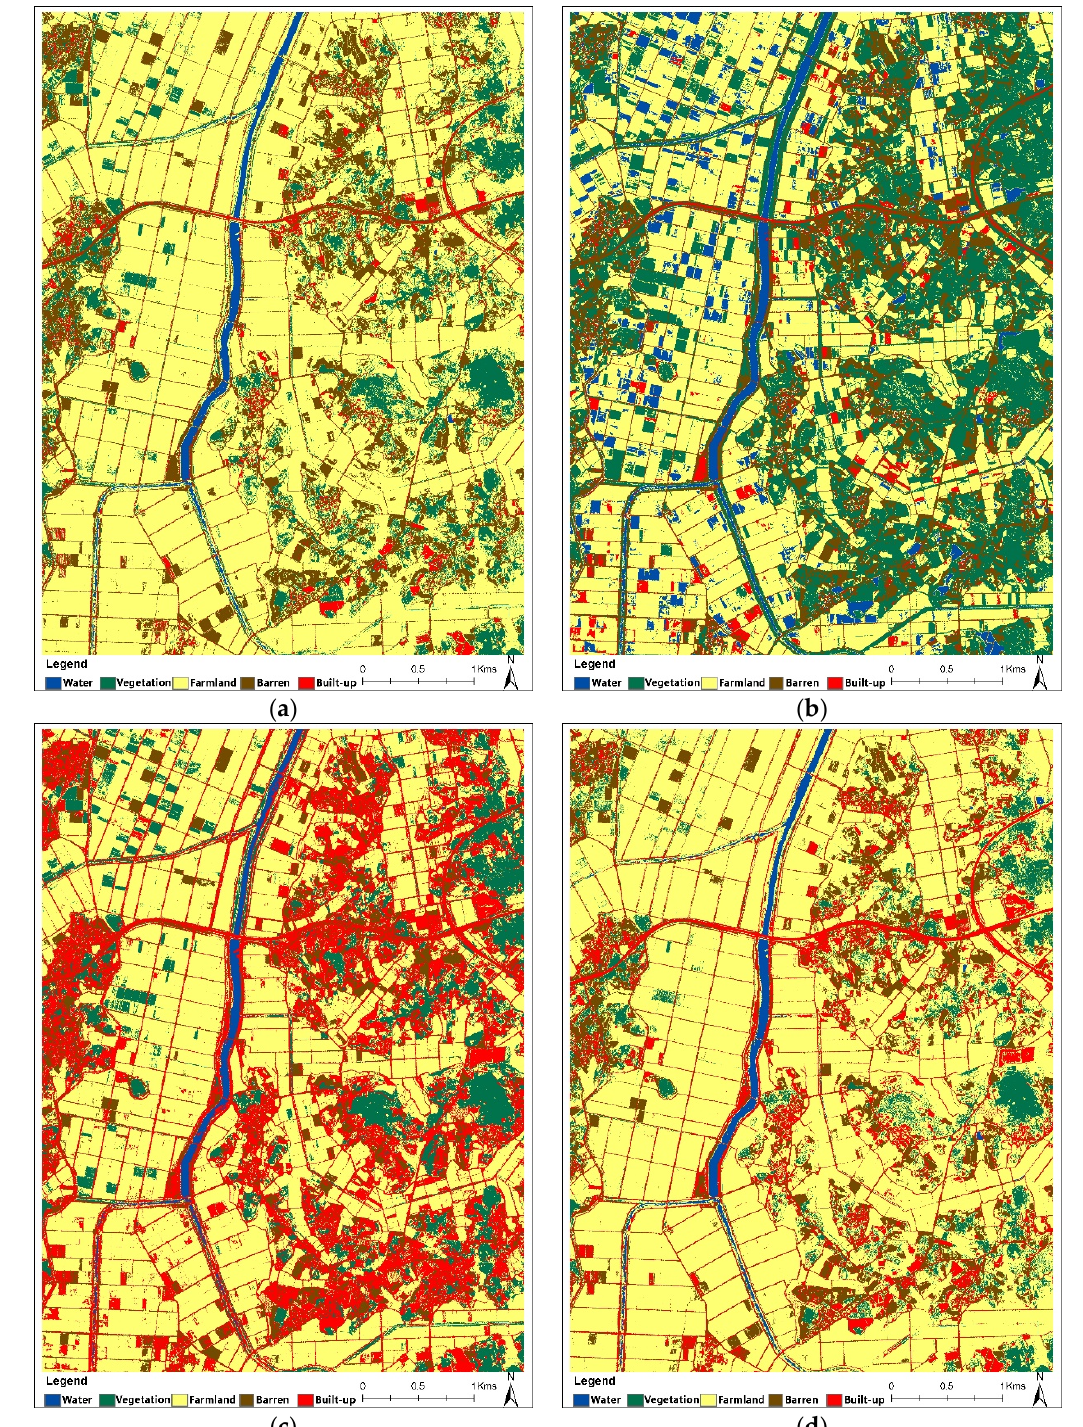
Figure 6. Land cover classification of the test site using ratio and indices bands composite: ( a ) MahD; ( b ) MinD; ( c ) ML; and ( d ) SVM.